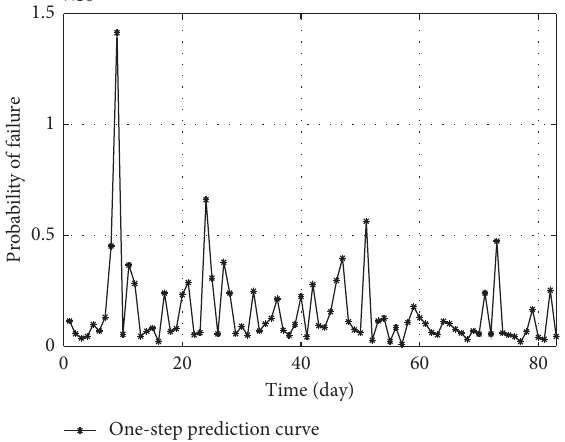
Figure 10: Predicted bridge failure